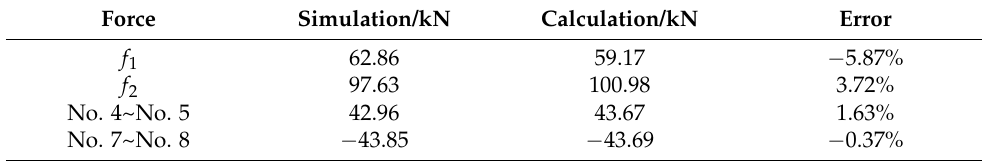
Table 8. The comparison of axial force between the simulation and the calculation results. Force Simulation/kN Calculation/kN